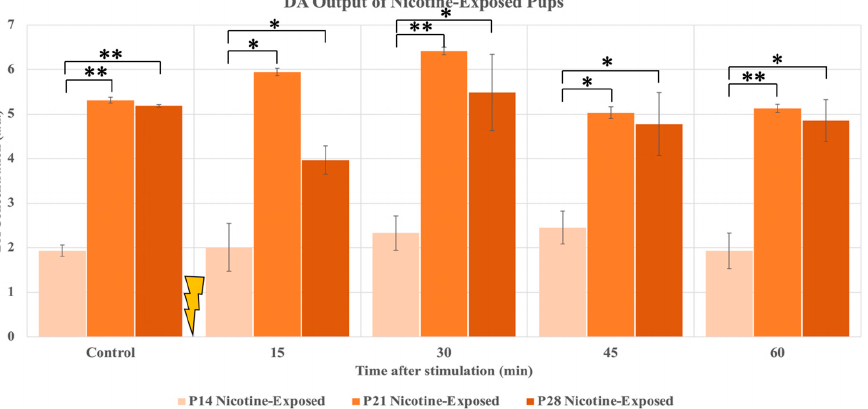
Figure 2. DA output of rat pups (P14, P21, P28) exposed to nicotine perinatally. Results are compared measurements of raw DA output into the extracellular space of the NAc. A significant difference was observed between the P14 pups and the P21 and P28 pups. ** denotes p < 0.01, ± standard deviation. * denotes p < 0.05, ± standard deviation.